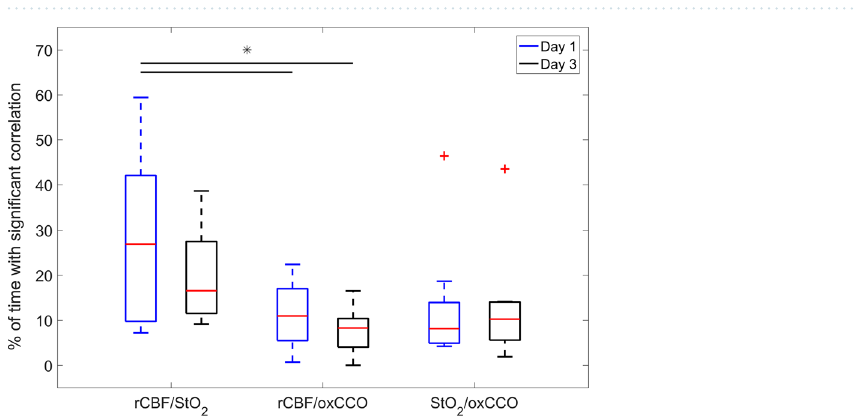
Figure 4. Boxplots of the fraction of time that coherence between two optical parameters reached the statistical threshold of 0.57. Data are presented separately for the two monitoring periods and for the three combinations of coherence estimates: rCBF/StO 2 , rCBF/ΔoxCCO and StO 2 /ΔoxCCO. Statistical outliers are indicated by + , and the bars indicate significant differences in coherence duration between rCBF/StO 2 on day 1 and rCBF/ ΔoxCCO on days 1 ( p = 0.025) and 3 ( p = 0.004). Details of each boxplot are as follows: rCBF/StO 2 (day 1): median: 26.9, 75th percentile: 42.1, 25th percentile: 9.8; rCBF/StO 2 (day 3): median: 16.6, 75th percentile: 27.5, 25th percentile: 11.5; rCBF/oxCCO (day 1): median: 11.0, 75th percentile: 17.0, 25th percentile: 5.5; rCBF/oxCCO (day 3): median: 8.3, 75th percentile: 10.4, 25th percentile: 4.0; StO 2 /oxCCO (day 1): median: 8.2; 75th percentile: 14.0; 25-th percentile: 4.9; and StO 2 /oxCCO (day 3): median: 10.3, 75th percentile: 14.1, 25th percentile: